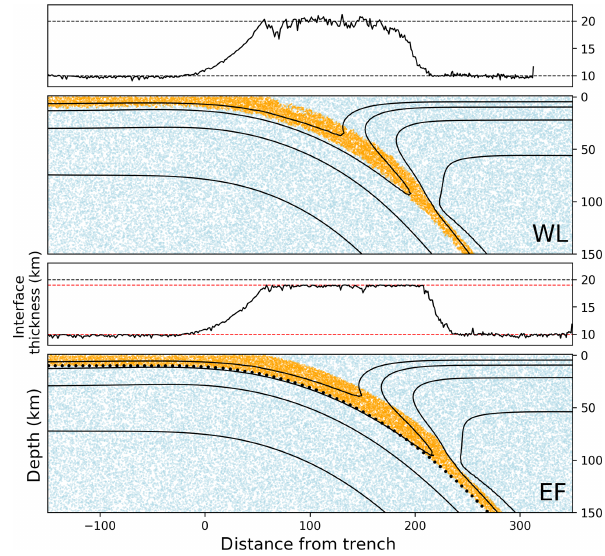
Figure 7. Distribution of subduction interface material. Results from a standard WL model are shown in the top panel. The EF model is shown in the bottom panel. Both models have a con- stant viscosity interface rheology. Model time is 12.5Myr in both cases. In the lower panels, orange points are the subduction inter- face material, and blue points are the background material (man- tle/lithosphere). Points in the material swarm and along the EF ref- erence line have been down-sampled for clarity. Solid black lines over the material points are isotherms. Smaller panels show the measured interface thicknesses in each case; red horizontal lines show the thickness constraints W min , W max